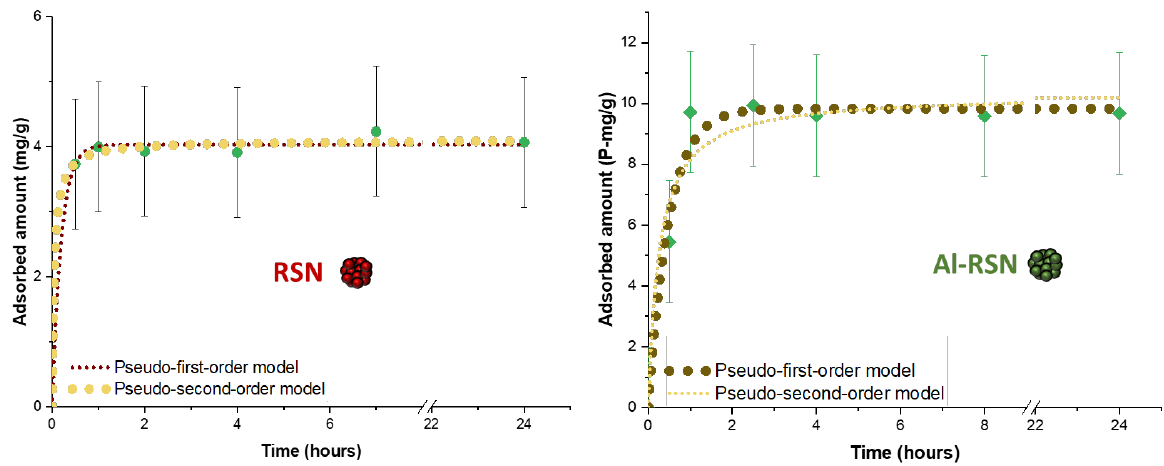
Figure 6. Adsorbed amount of phosphate by RSNs (left) and Al-RSNs (right) in a phosphate solution (50 P-mg·L − 1 ) at pH 7 for different durations.